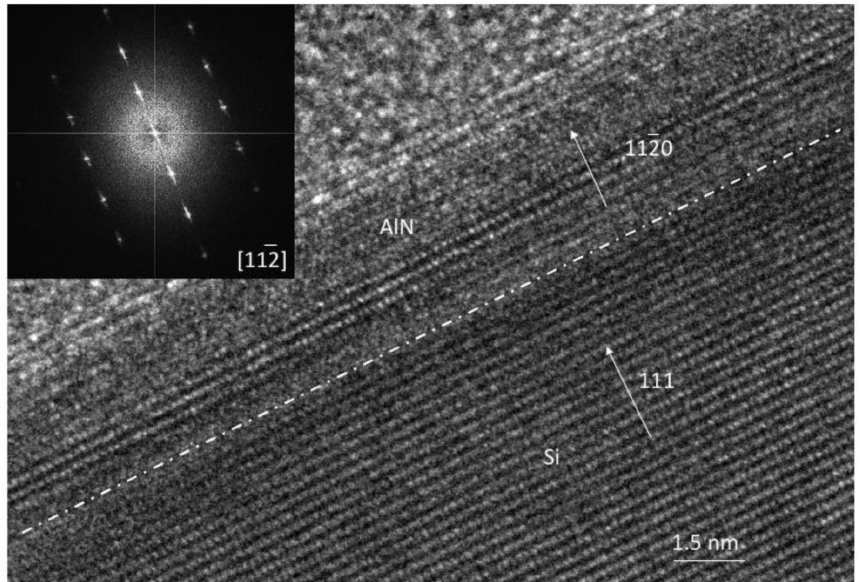
Figure 3. HRTEM image showing a rather sharp AlN/Si interface near the [11-2] zone of the substrate. FFT from the substrate and the film has been shown as an inset.